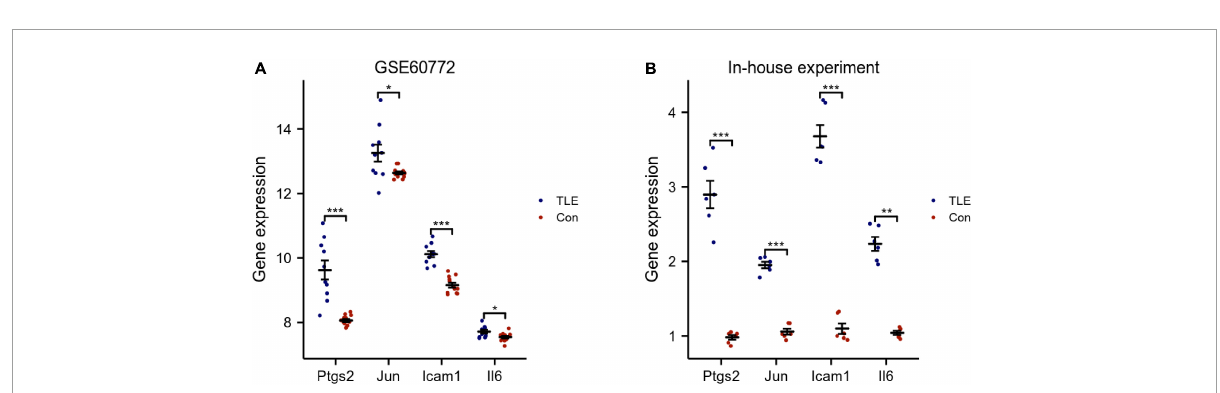
FIGURE4 Validation of hub genes. (A) Validation of hub genes by an external dataset (GSE60772). (B) Verification of hub genes by an in-house experiment. The findings showed that Ptgs2, Jun, Icam1, Il6 expression levels were all increased in TLE group. Data were presented as mean ± standard deviation (SD). n = 3. * P < 0.05, ** P < 0.01, *** P <